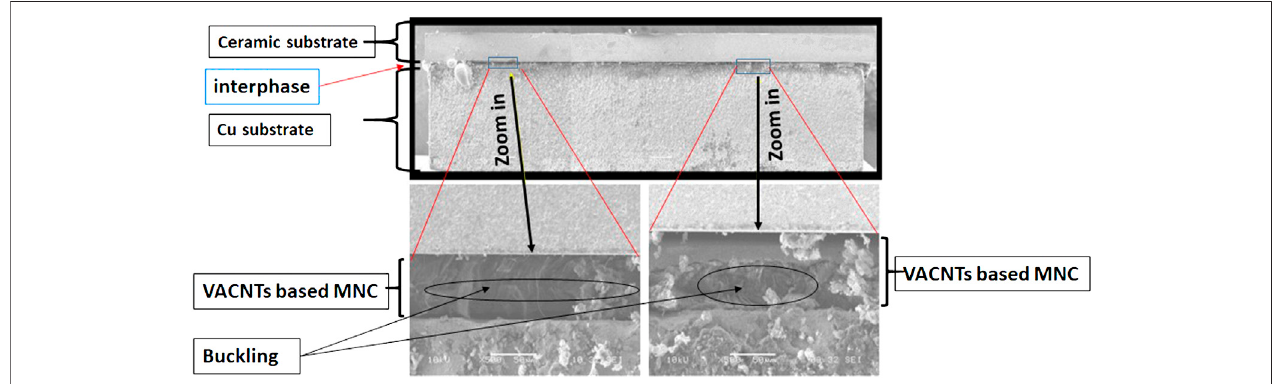
FIGURE 9 | Side view of fabricated sandwich sample (top) and MNC interphase (bottom) . (Top scale bar (cid:2) 500 µm; Bottom scale bar (cid:2) 50 µm).